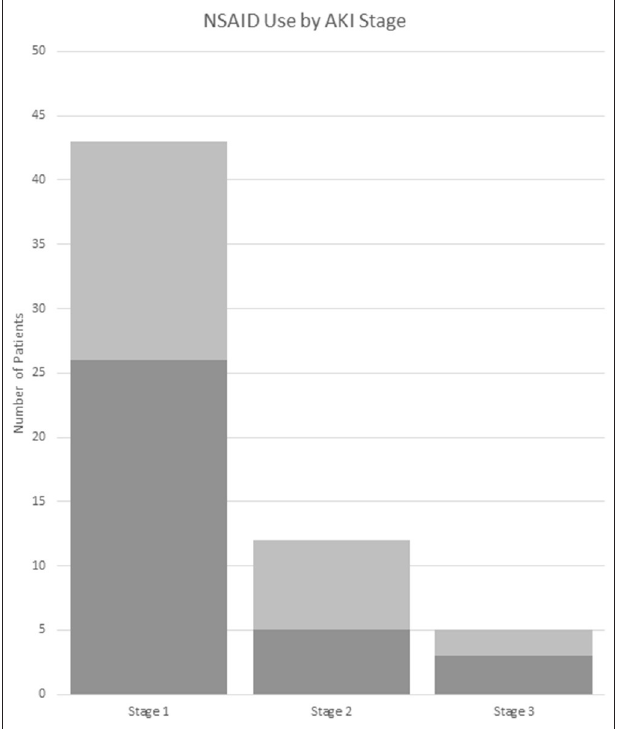
FIGURE 4 | NSAID use by AKI stage. Dark gray: received NSAIDs. Light gray: did not receive NSAIDs. AKI stage is chosen by the highest stage met of any the pRIFLE, AKIN, or KDIGO criteria. NSAID, non-steroidal anti-inflammatory